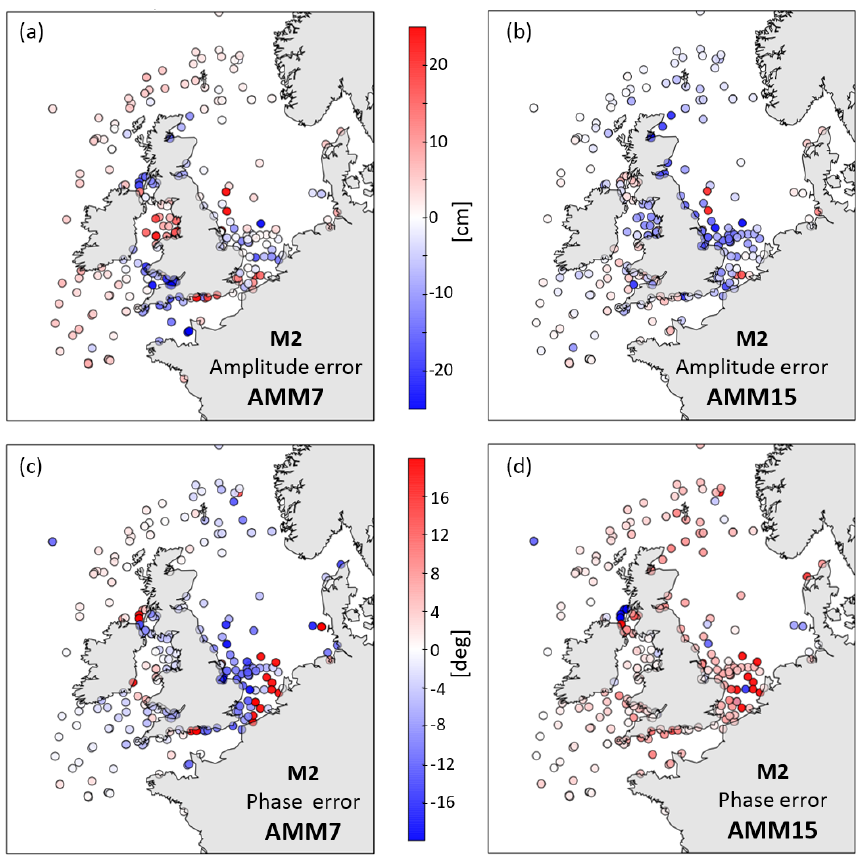
Figure 6. M2 amplitude (a, b) and phase (c, d) error relative to observations (observation–model) for AMM7 (a, c) and AMM15 (b, d) .